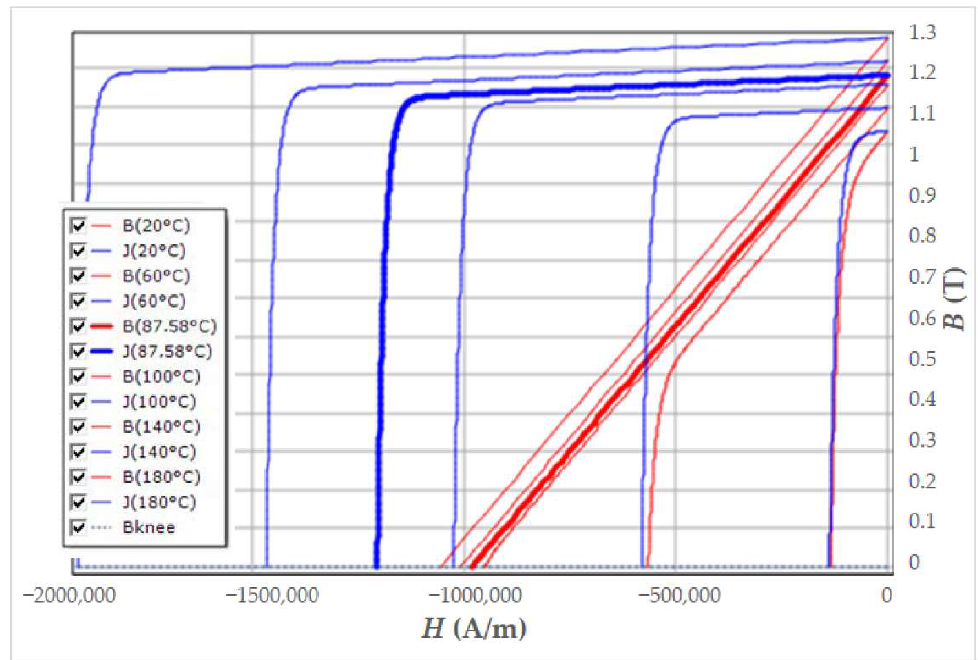
Figure 39. Demagnetization characteristics of the permanent magnets used in the model .